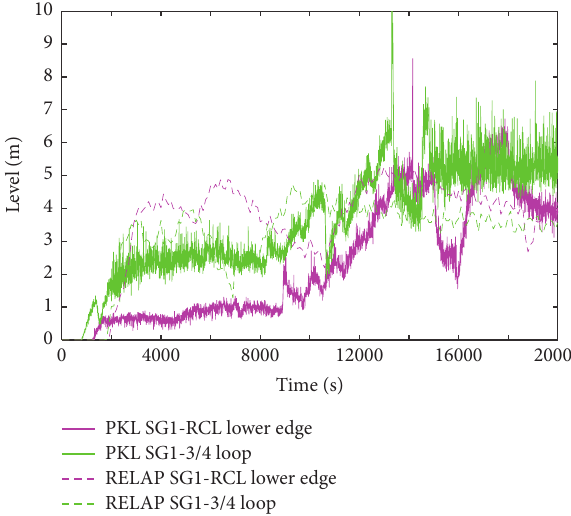
Figure 3: Inlet U-tubes SG1 levels. PKL versus RELAP5. Level influence. Phase I.